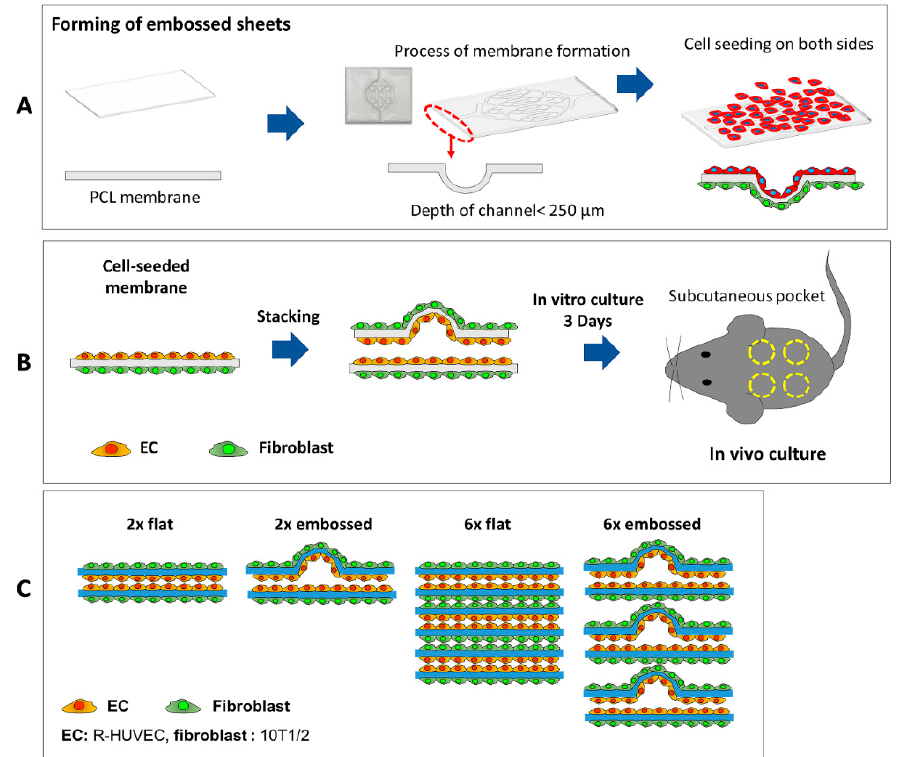
Figure 1. Generation of electrospun membranes with embossed patterns for guided vascularization of seeded cells. ( A ) Schematic diagram of forming of embossed sheet followed by seeding with human endothelial and mouse fibroblast cells. ( B ) Cell-seeded embossed sheets were stacked and cultured for 3 days before implantation into subcutaneous pockets in mice. ( C ) Experimental groups for in vivo experiment included stacks of two flat membranes (group 2× flat), an embossed membrane stacked on a flat membrane (group 2× embossed), six layers of flat membranes (group 6× flat), and six layers of alternating flat and embossed membranes (group 6× embossed).